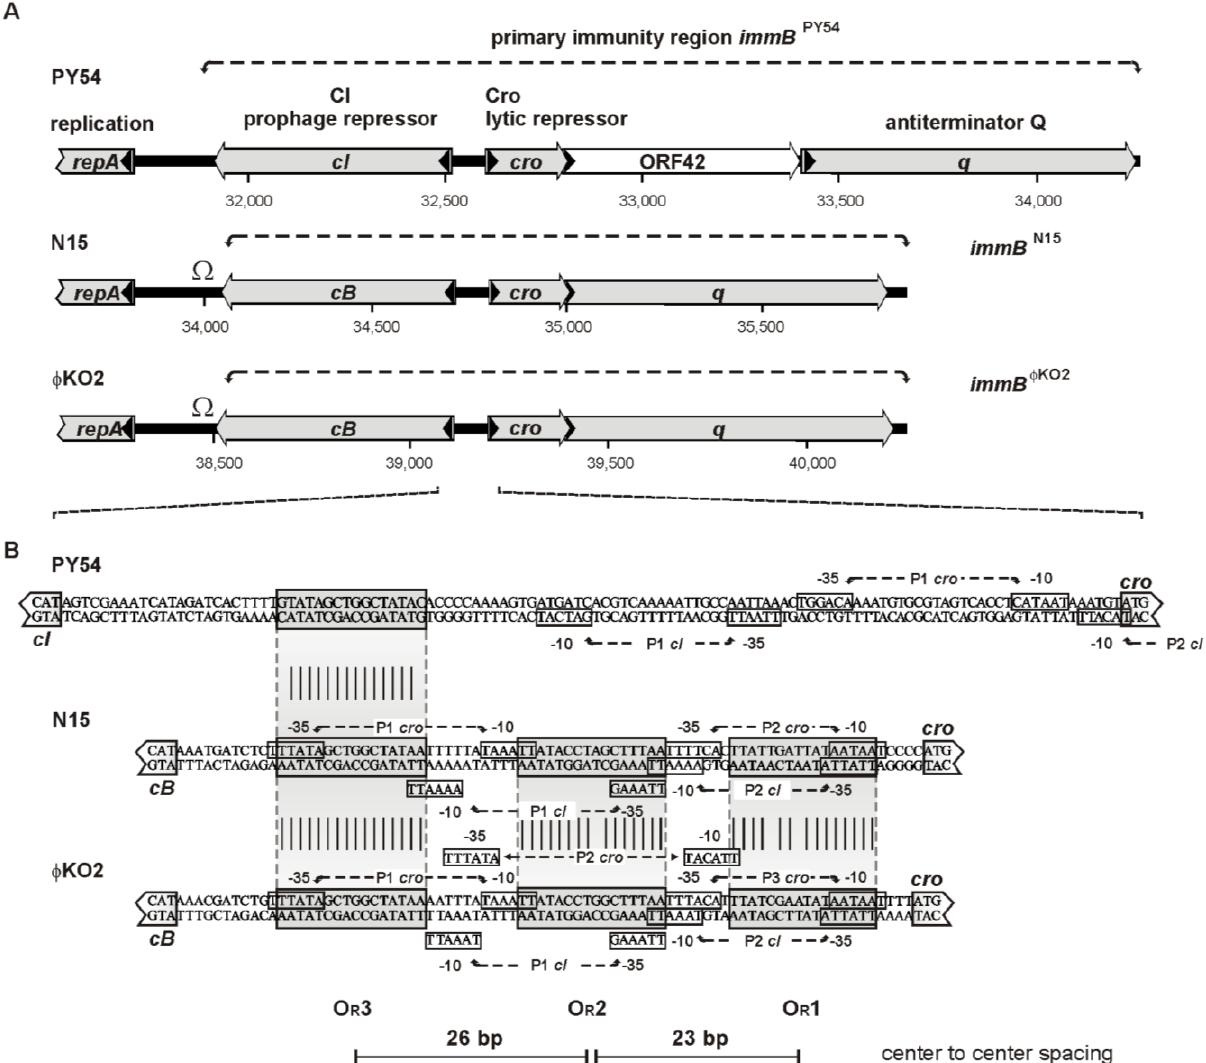
Figure 2. Organization of the primary immunity region ( immB ) of the linear plasmid prophages PY54, ϕKO2 and N15. ( A ) Genetic map of immB . Functional assignments were made according to Hertwig et al. [13], Casjens et al. [1], and Ravin et al. [14]. The transcription directions are indicated by arrows, Ω, transcriptional terminators identified in ϕKO2 and N15; ( B ) Sequence alignment of the intergenic regions between the repressor genes cI ( cB ) and cro . Operator sequences of N15 determined by Lobocka et al. [6] and similar sequences in the corresponding regions of PY54 and ϕKO2 are presented in light shaded boxes. Nucleotides within the PY54 and ϕKO2 operator sequences identical to those of the corresponding N15 sites are marked by vertical lines. Predicted promoters of cI and cro are shown.